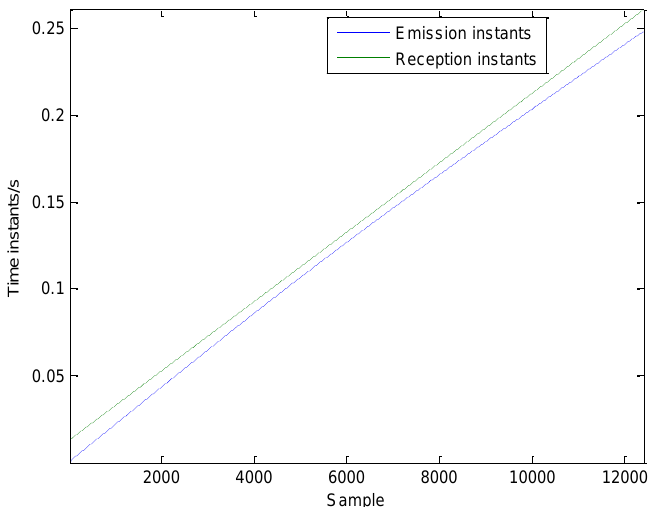
Figure 5. The emission and reception time